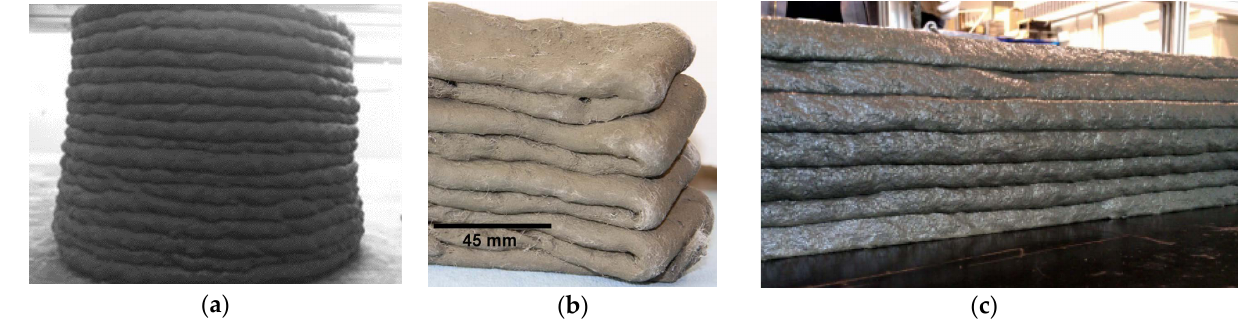
Figure 2. Examples of surface quality of printed SHCC: ( a ) mixture with 2% fiber [25], ( b ) mixture with 2% fiber [28], and ( c ) mixture with 1% fiber [23]; fiber content is given in % by volume.